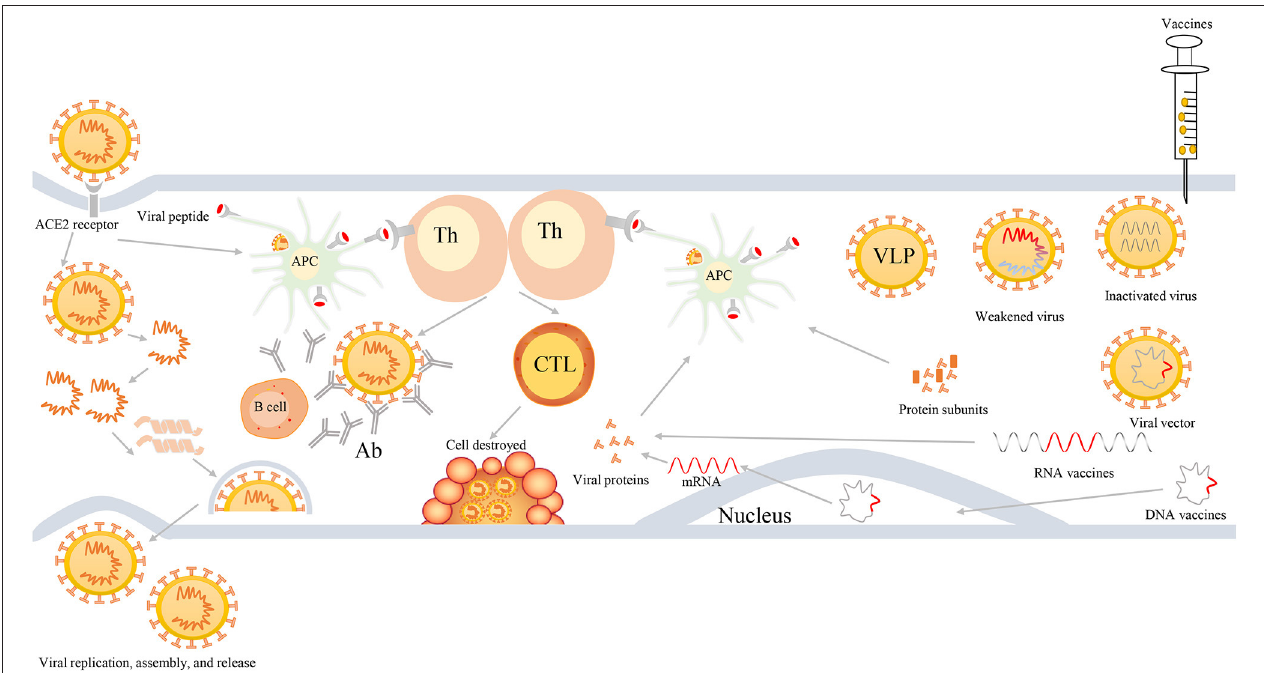
FIGURE 3 | The process of viral infection and induced bodies to generate immune responses after infection or inoculation of vaccines. First, SARS-CoV-2 viruses enter into cells via binding to ACE2 receptors, then they release their genetic materials, accomplish replicate, translate RNA into proteins, assemble viruses, and finally release a multitude of viruses. Second, individuals also harbor unique immune mechanism to fight against SARS-CoV-2 infection. When viruses enter into cells, APCs will ingest viruses and initiate immune responses via the recognition of viral peptide by MCH molecules. APCs can present the information of viral antigens to Th cells. Subsequently, Th cells are capable of activating humoral immunity to generate antibodies and cell-mediated immunity to lyse and kill viruses. Third, when individuals are inoculated with vaccines, such as weakened or inactivated viruses, viral vector, nucleic acid (DNA or RNA), and protein-based (protein subunits or VLP) vaccines, they can produce effective immune responses to defend infection against SARS-CoV-2 and its variants. Th, T-helper; APC, antigen presenting cells; CTL, cytotoxic T cell; Ab, antibodies; VLP, virus-like